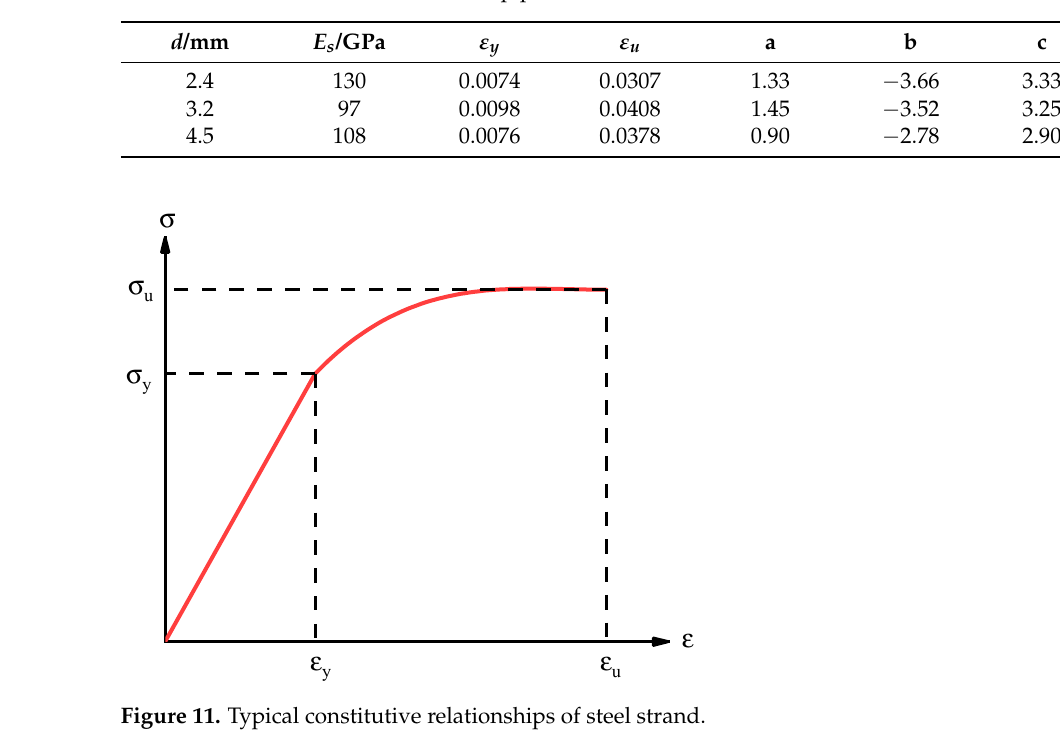
Table 4. List of constitutive relationship parameters.